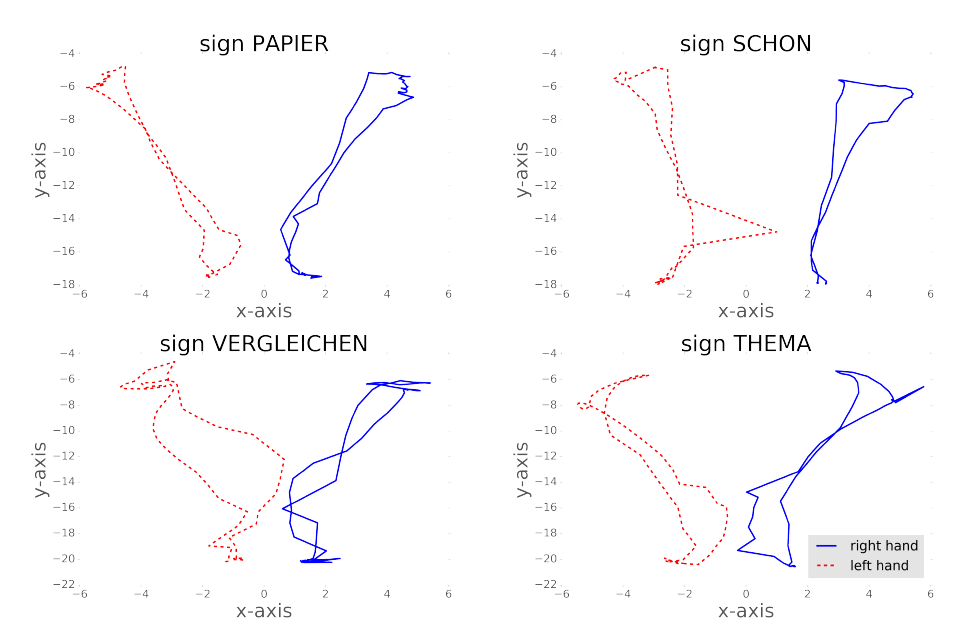
Figure 6. ( x , y ) movement of the right and left (dashed line) hands of the signs PAPIER, SCHON, VERGLEICHEN and THEMA,